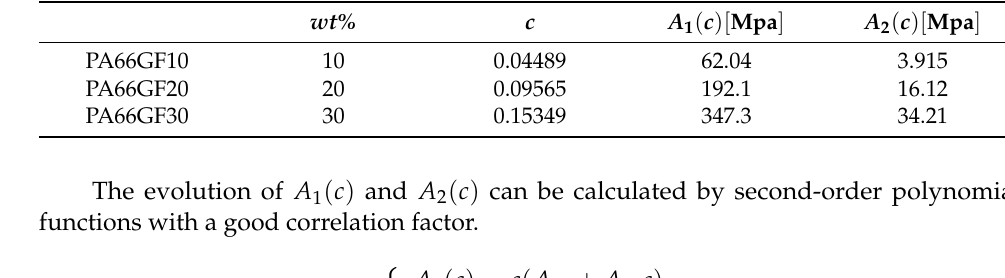
Table 1. Identification of the material parameter A 1 ( c ) and A 2 ( c ) .